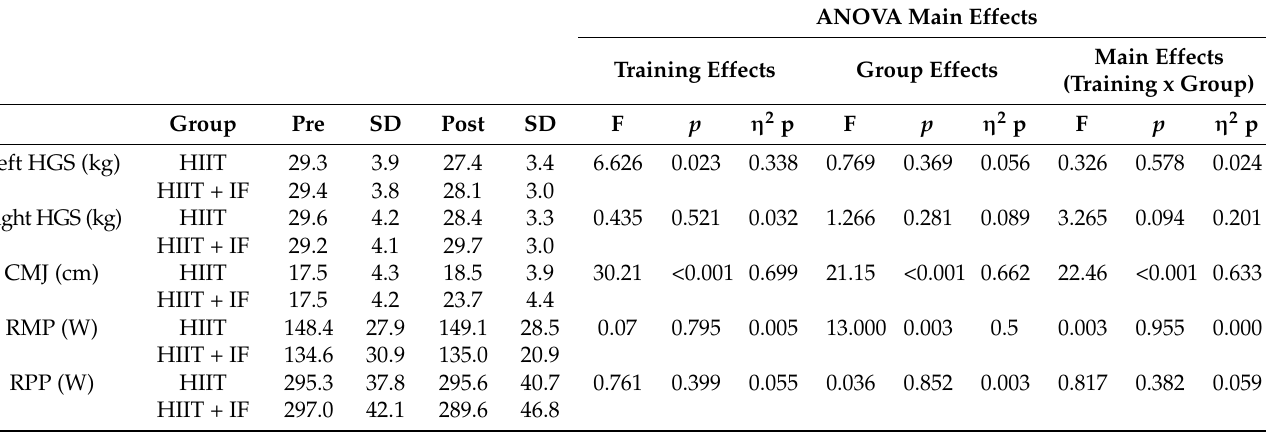
Figure 4. Effects of training on body composition (mean difference post-training vs. pre-training: mean ± standard deviation). d, effect size, significant differences between pre- and post-training, * = p < 0.05. Table 3. Changes in muscular and anaerobic